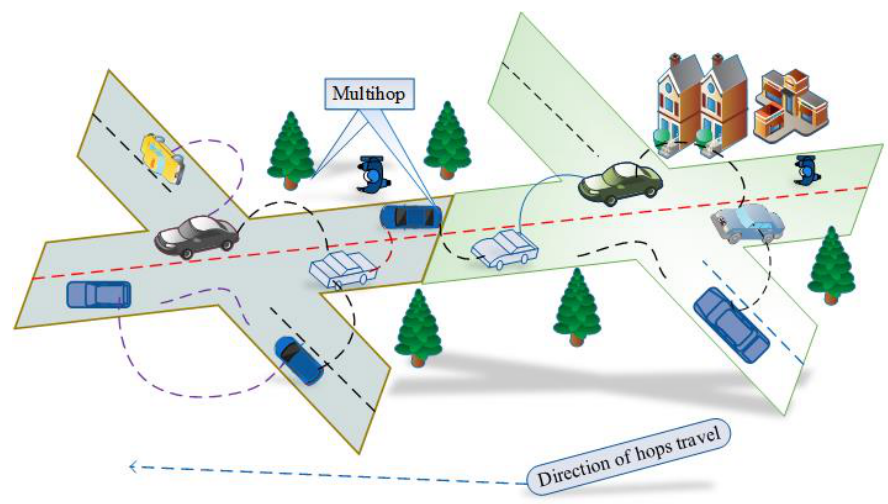
Figure 1. Vehicle–vehicle communication in multi-hop